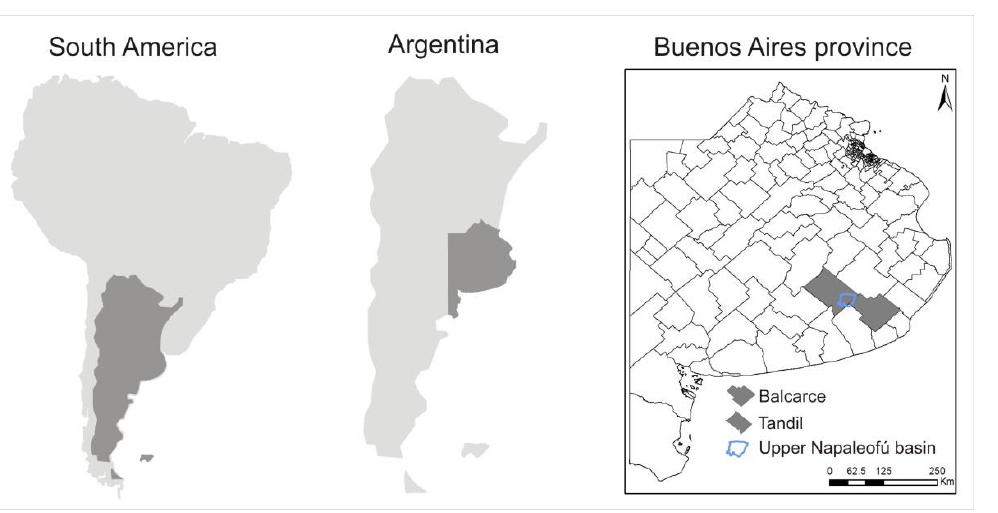
Figure 2. Location of Argentina in South America (left), location of Buenos Aires province in Argentina (middle), and location of Tandil and Balcarce districts and the upper Napaleofú basin in Buenos Aires province (right).